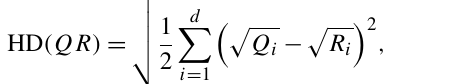
Figure 1. Lena River catchment (black outline) on topographic map (colour coded) and position of short- and long-term meteorologi- cal stations used to test reanalysis and interpolated datasets. Of the long-term stations, Kyusyur has the lowest temporal coverage (less than 10 years) in the reference period